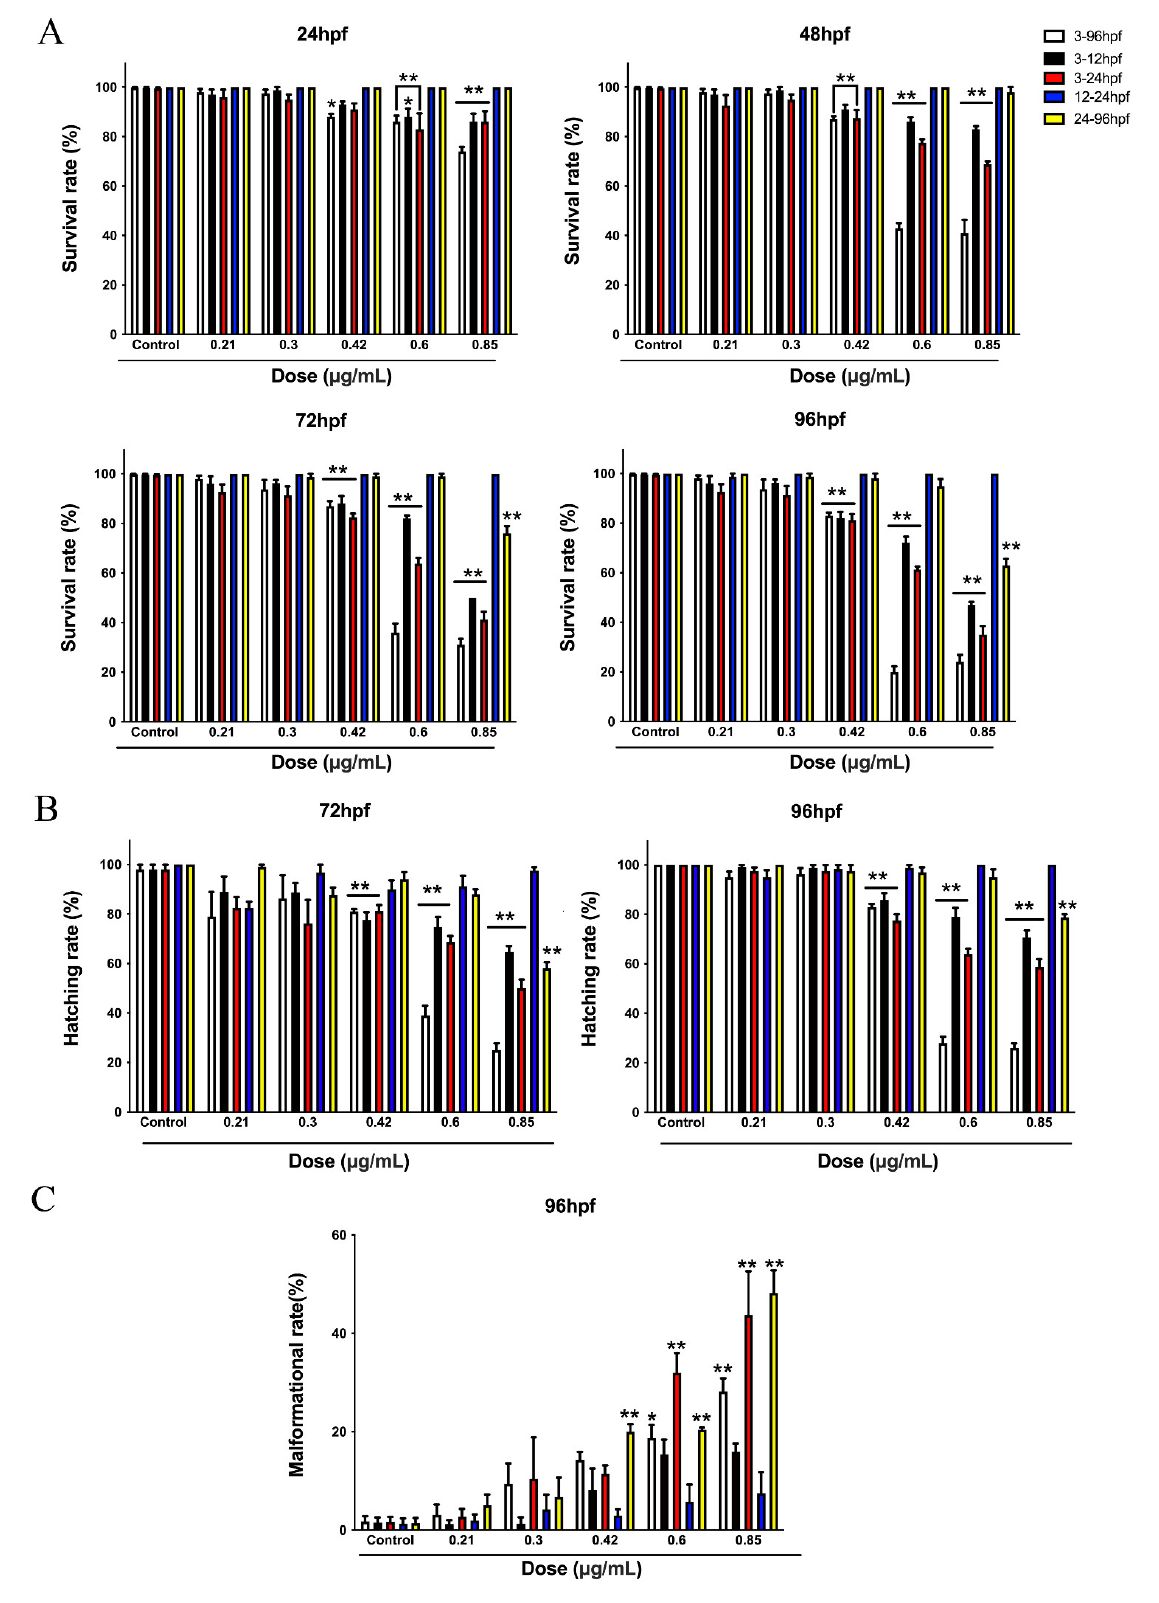
Figure 2. Relationship between the honokiol microemulsion exposure period and the toxic response. ( A ) Survival rates of zebrafish embryos at 24, 48, 72 and 96 hpf. ( B ) Hatching rates of zebrafish embryos at 72 and 96 hpf. ( C ) Malformation rates of zebrafish at 96 hpf. The data are expressed as the mean ± SD (* p < 0.05, ** p < 0.01 compared with control